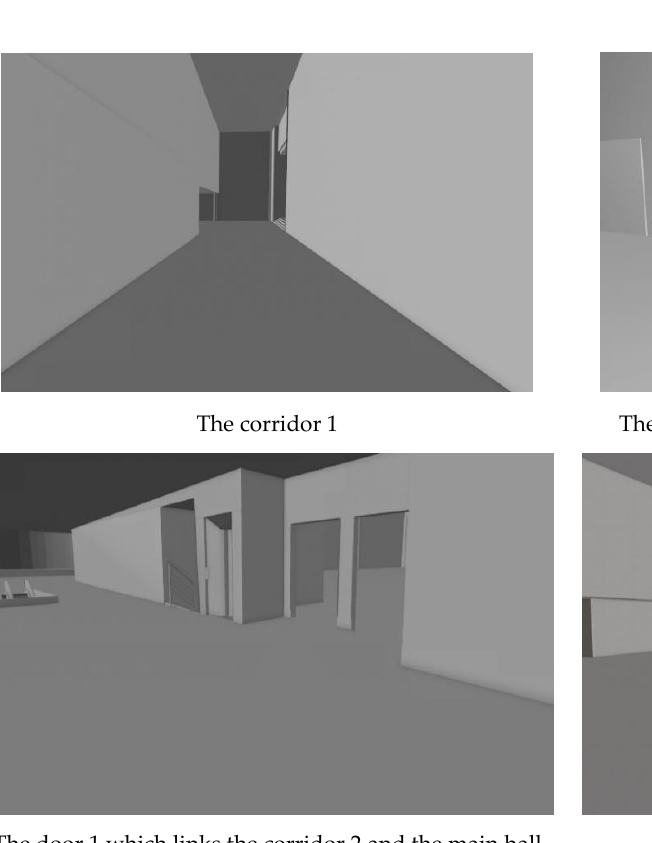
12 of 21 Figure 7. Quebec Convention Center building, ( a ) 3D point cloud, and ( b ) 3D vector model. The 3D model of the indoor environment selected for this experiment was composed of about 1000 surfaces, including walls and ceilings on which the sensors were deployed. As depicted in the Figure 8, the management of these surfaces as well as their topological relations in 3D space is much more complex compared to a simple 2D representation of the environment. Sensor deployment cannot be easily accomplished in such an environ- ment because of the differences in the heights of ceilings and complexities of topology between the walls and ceiling surfaces (Figure 8). In addition, there were many obstacles that complicate sensor placement and the optimization process. In our case study, the 3D environment included nine columns in the main hall. These columns were modeled as cylinders that were themselves composed of many smaller surfaces. In addition, several non-convex surfaces had to be managed inside the corridors and the main hall. These sur-